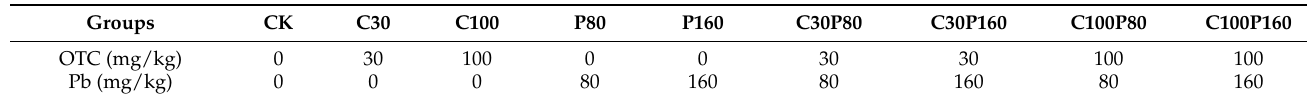
Table 2. Concentration design of each experimental group.